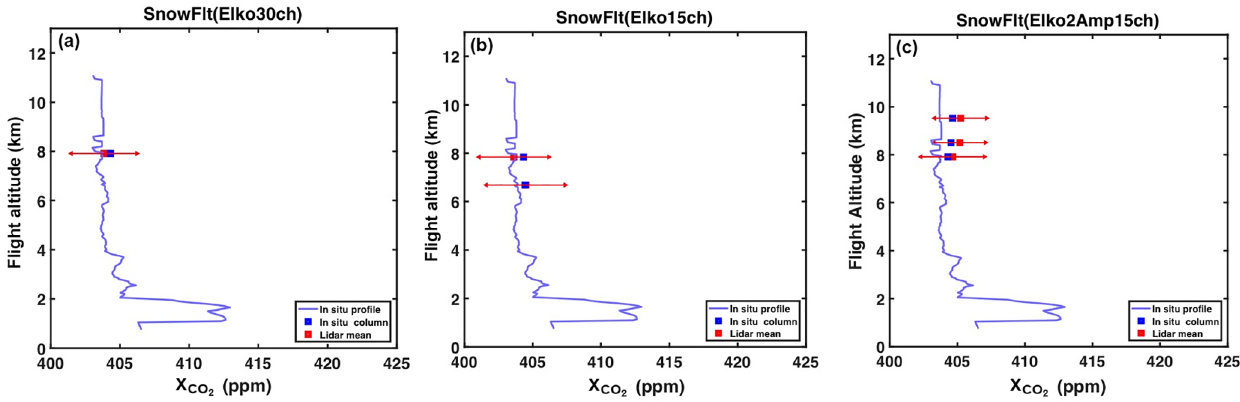
Figure 25. Lidar results from the 2016 snow flight. (a) Plot of the XCO 2 measurements from the lidar (in red) from the plotted altitude to the surface, the in situ CO 2 concentration measurements (blue line) and the XCO 2 computed from the in situ CO 2 readings (blue dots) from the plotted altitude to the surface (blue dots). Here the lidar measurements were made using 30 laser wavelength samples across the CO 2 line. (b) Results over the same snow area, but lidar measurements were made using 15 wavelength samples across the CO 2 line. (c) Results over the same snow area, but with lidar measurements made using 15 wavelengths and using two EDFA laser amplifiers in parallel.